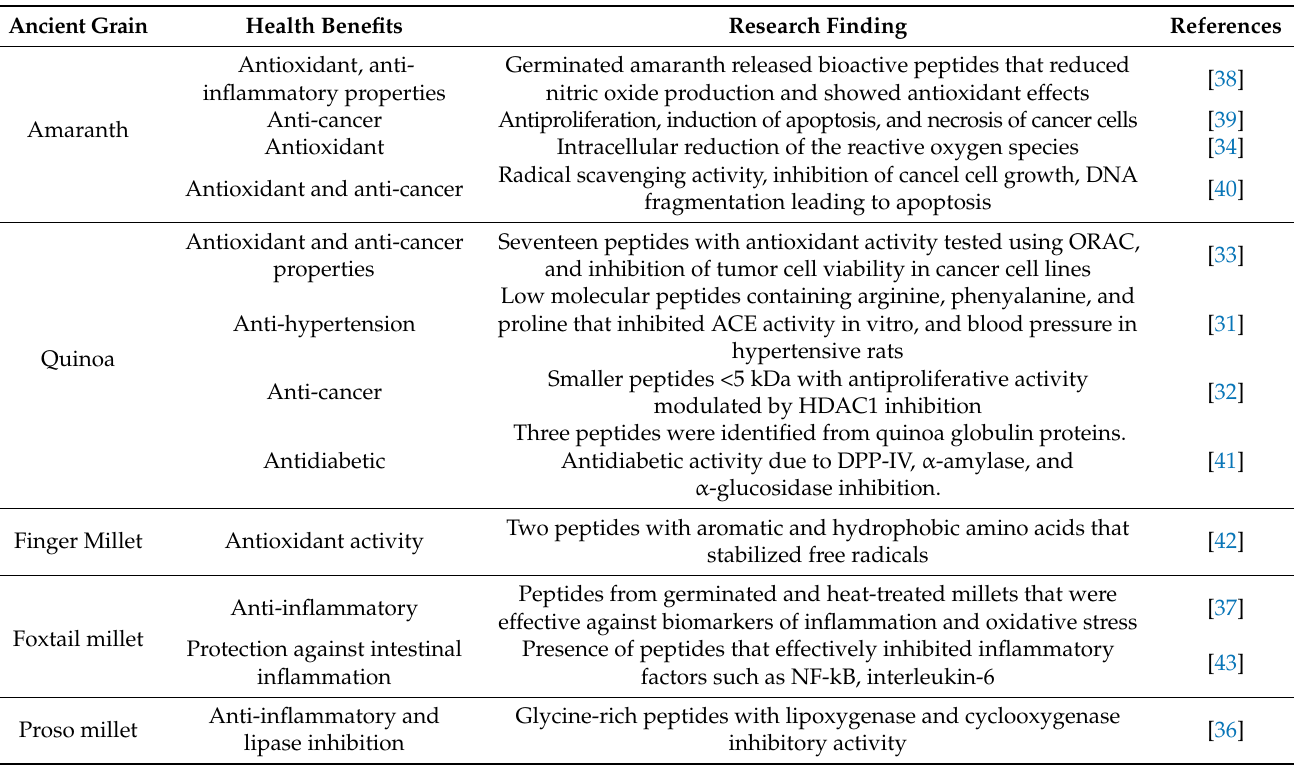
Table 2. Summary of recent studies that assessed the health benefits of ancient grain bioactive peptides after in vitro gastrointestinal